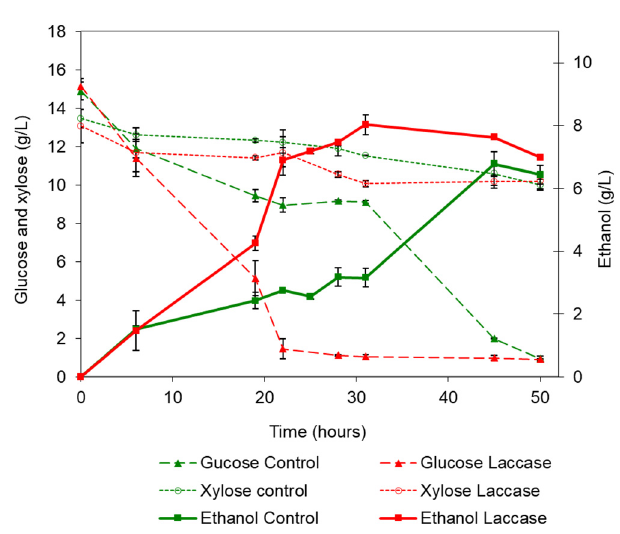
Figure 4. Time course for fermentation of control and laccase-treated liquid fraction enzymatic hy- drolysates using S. cerevisiae Ethanol Red. Concentrations (g/L) of glucose and xylose and production (g/L) of ethanol are shown.